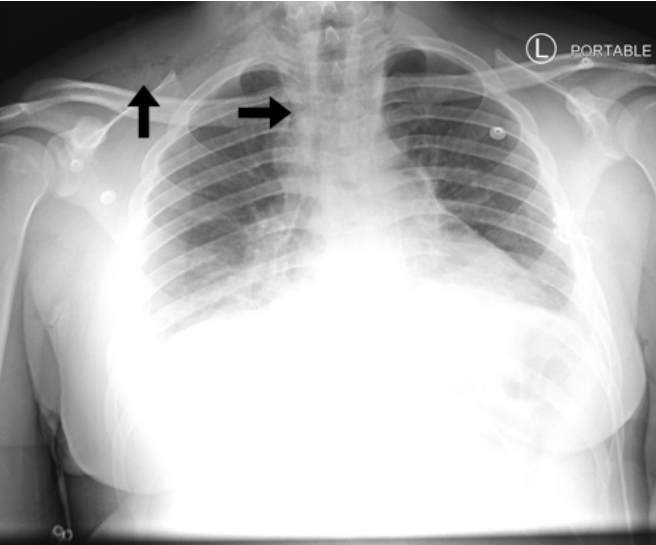
Image 2 . Chest radiograph demonstrating pneumomediastinum and subcutaneous emphysema just above the right clavicle (arrows).